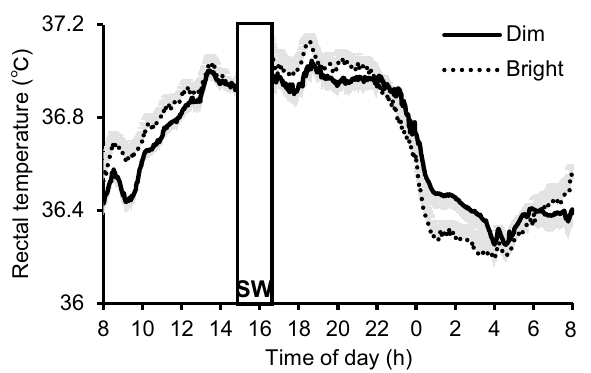
Figure 2. Mean diurnal rhythms in RT under the two light conditions. SW, no data due to shower time. Light grey shading indicates SEM. N =